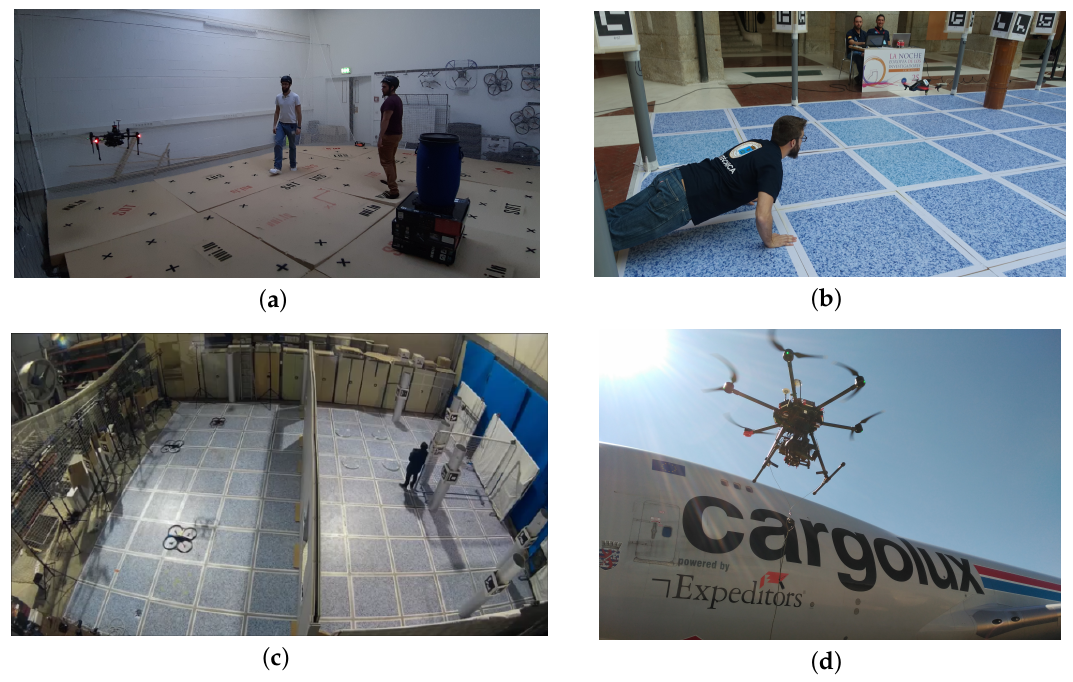
Figure 2. Examples of UAV applications, where situational awareness and object detection algorithms wereused. ( a )Obstacleavoidanceusing2DLiDAR[42]. ( b )PersonfollowingusingRGBcamera[46]. ( c )Target detection using RGB camera [34]. ( d ) Airframe inspection using RGB camera, project FNR-PoC AFI,